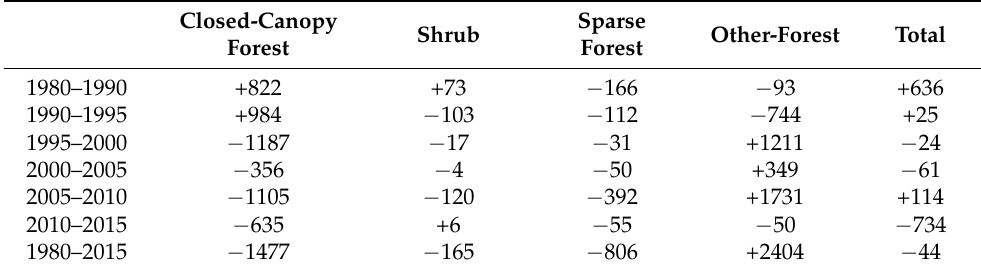
Table 1. Temporal change of forest types in GHKM from 1980 to 2015 (km 2 ). (“+” indicates increase, “ − ” indicates decrease). Closed-Canopy Sparse Shrub Other-Forest Forest Forest